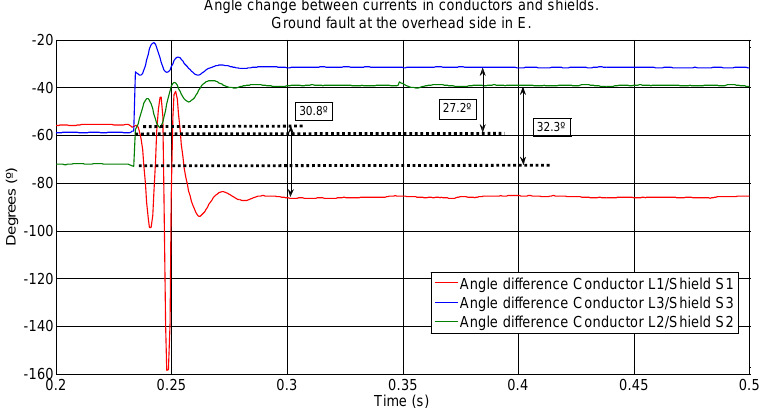
Figure 17. Angular differences with ground fault at the overhead side in phase L1. Fault point E.